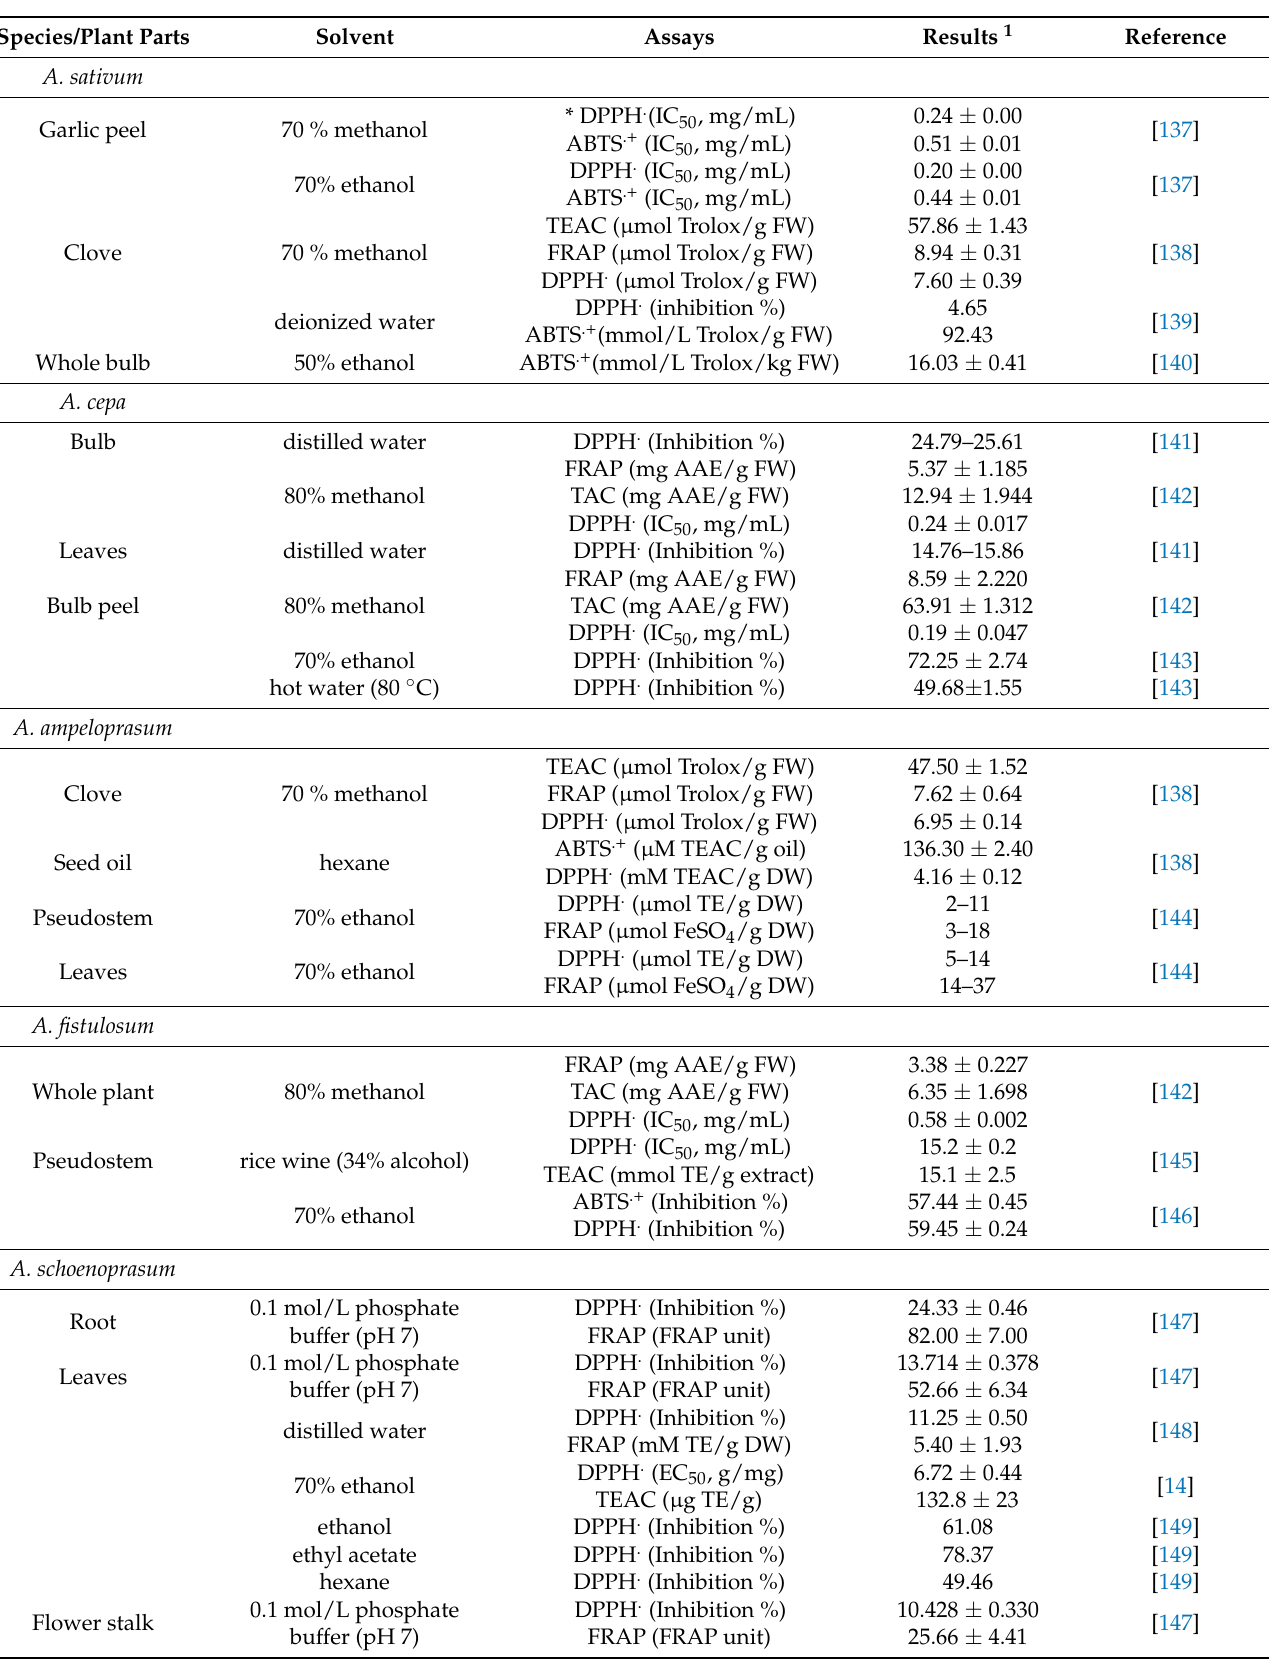
Table 2. Antioxidant activity of Allium species recorded in different